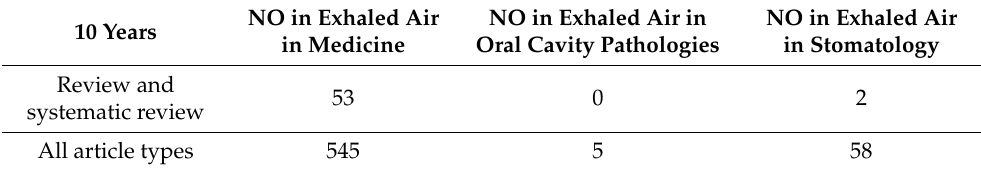
Table 1. Number of literature positions in 10 years according to